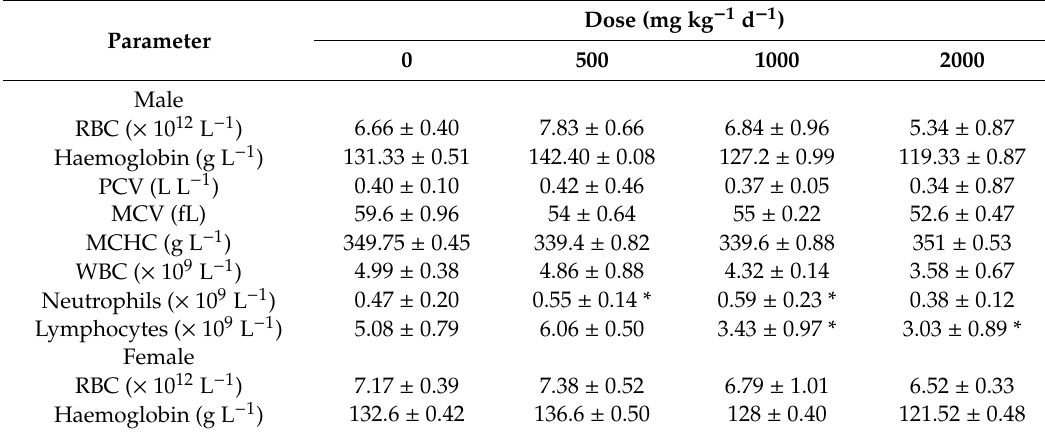
Table 6. Haematology data for male and female rats treated with oral palm puree for 28 d.